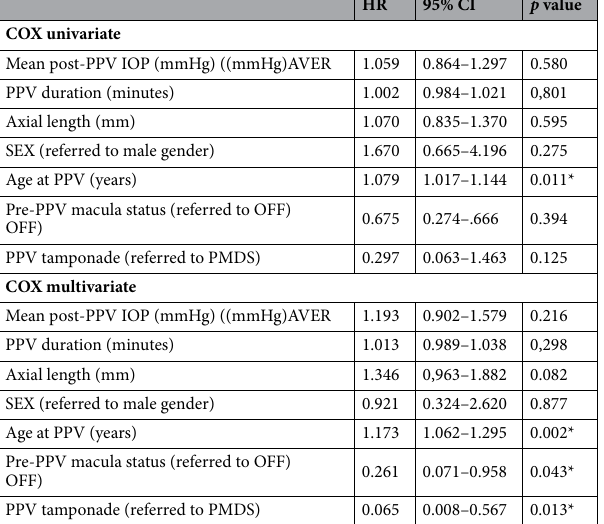
Table 3. Univariate (upper part) and multivariate (lower part) COX regression analyses referred to the development of the indication for cataract extraction